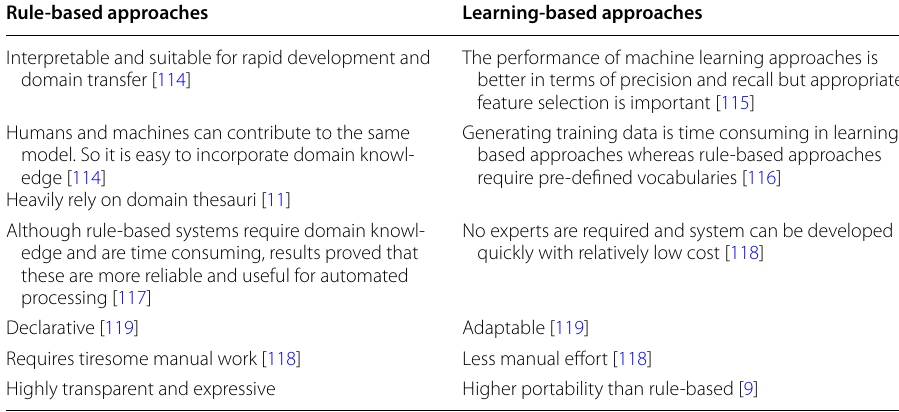
Table 8 Rule-based vs learning-based techniques Rule‑based approaches Learning‑based